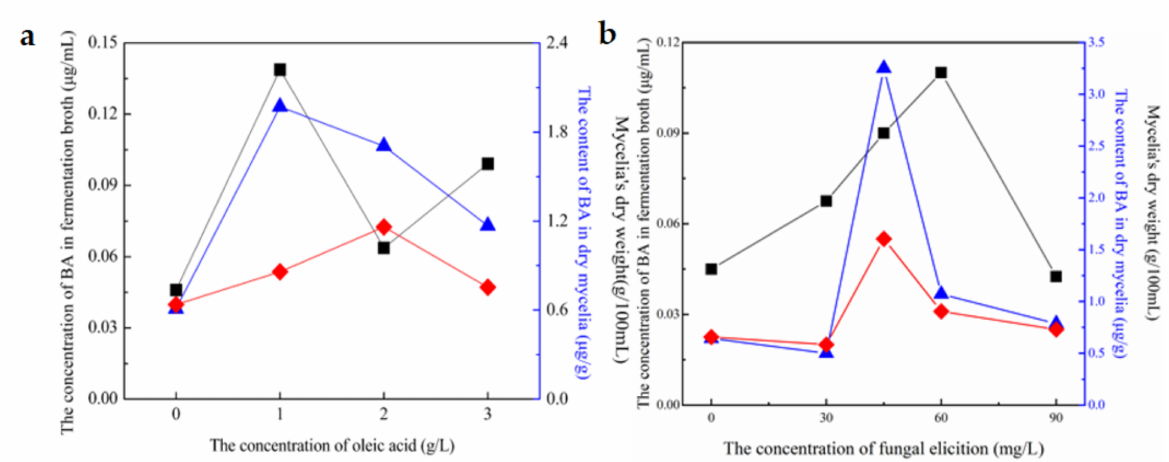
Figure 3. Effects of oleic acid’s concentration ( a ) and fungal elicitor’s concentration ( b ) on fermentation progress. BA’s concentration in fermentation broth; BA’s content in dry mycelia; Mycelia’s dry weight.